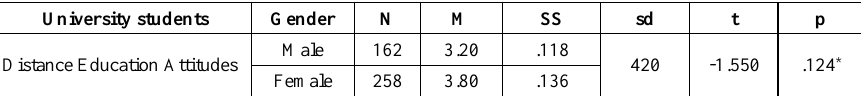
Table 5. Distance education attitudes of university students by